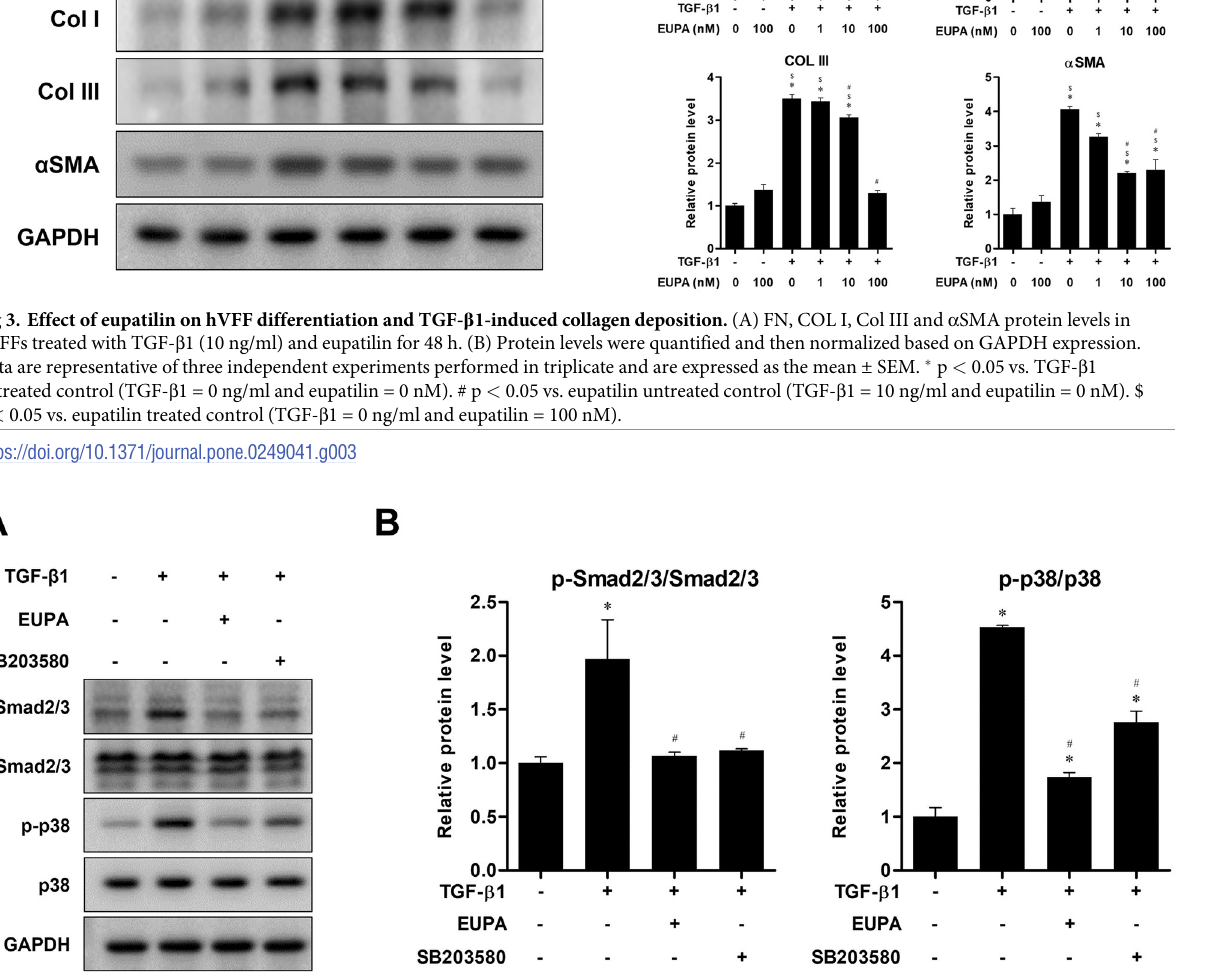
Fig 4. Effect of eupatilin on the TGF- β 1-induced phosphorylation of Smad2/3, and p38 in hVFFs. (A) p-Smad2/3, and p-p38 protein levels in hVFFs treated with TGF- β 1 (10 ng/ml) for 48 h in the presence or absence of SB203580 (10 μ M) or eupatilin (100 nM). (B) Phosphorylation levels were quantified by densitometry and are presented as the ratio between the optical density of p-Smad2/3 and total Smad2/3, and p-p38 and total p38. Data are representative of three independent experiments performed in triplicate and are expressed as the mean ± SEM. � p < 0.05 vs. TGF- β 1 untreated control (TGF- β 1 = 0 ng/ml). # p < 0.05 vs. eupatilin untreated control (eupatilin = 0